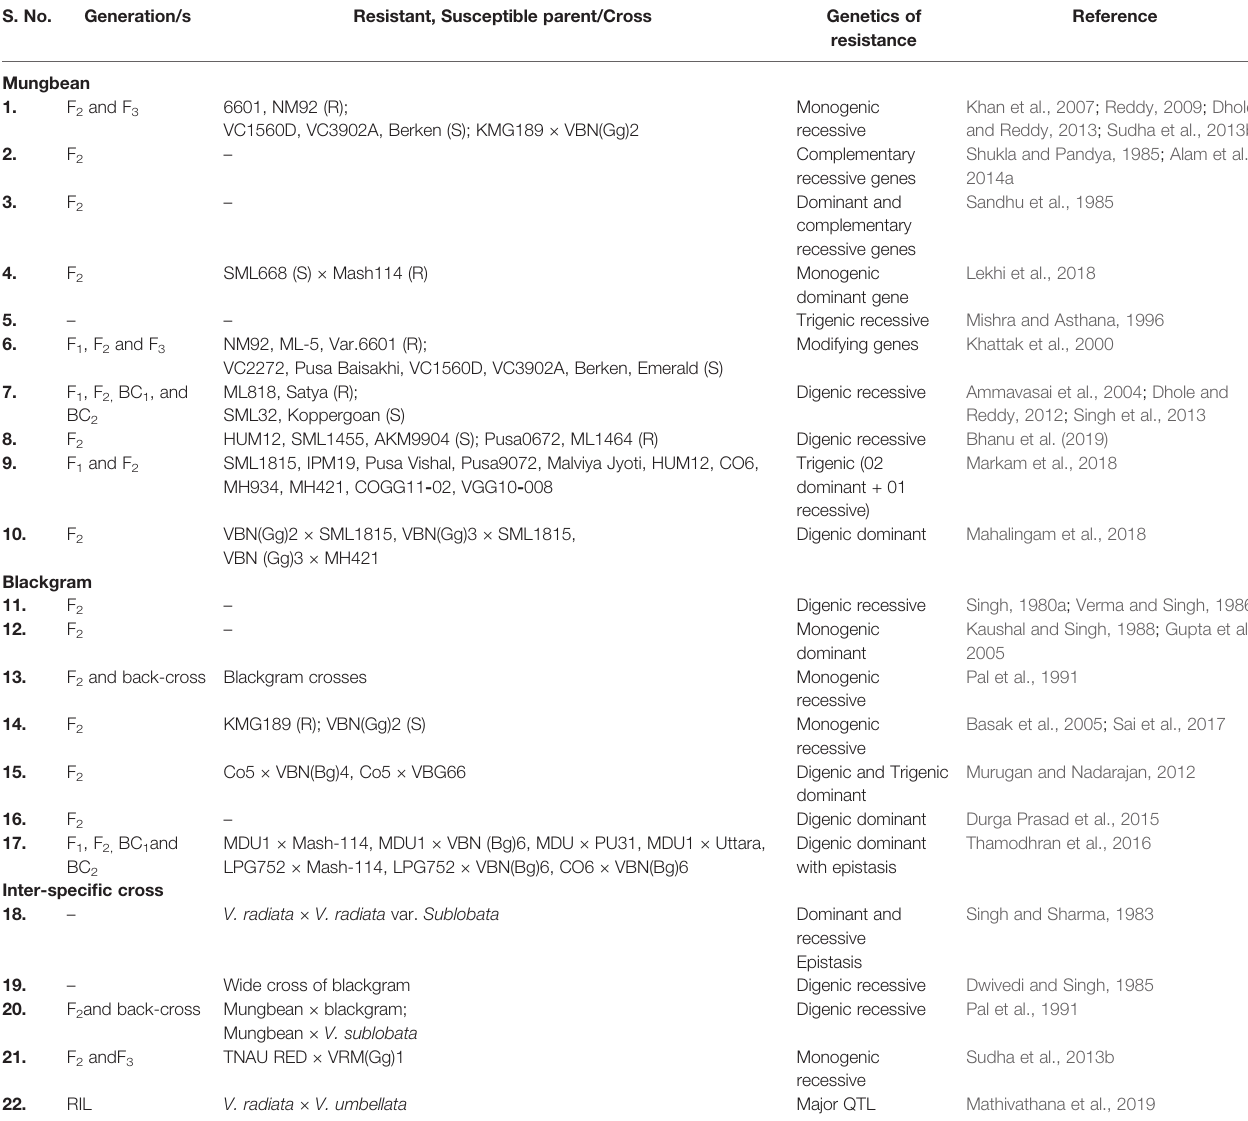
TABLE 1 | Genetics of MYMV resistance in mungbean, blackgram, and interspeci fi c crosses. S.